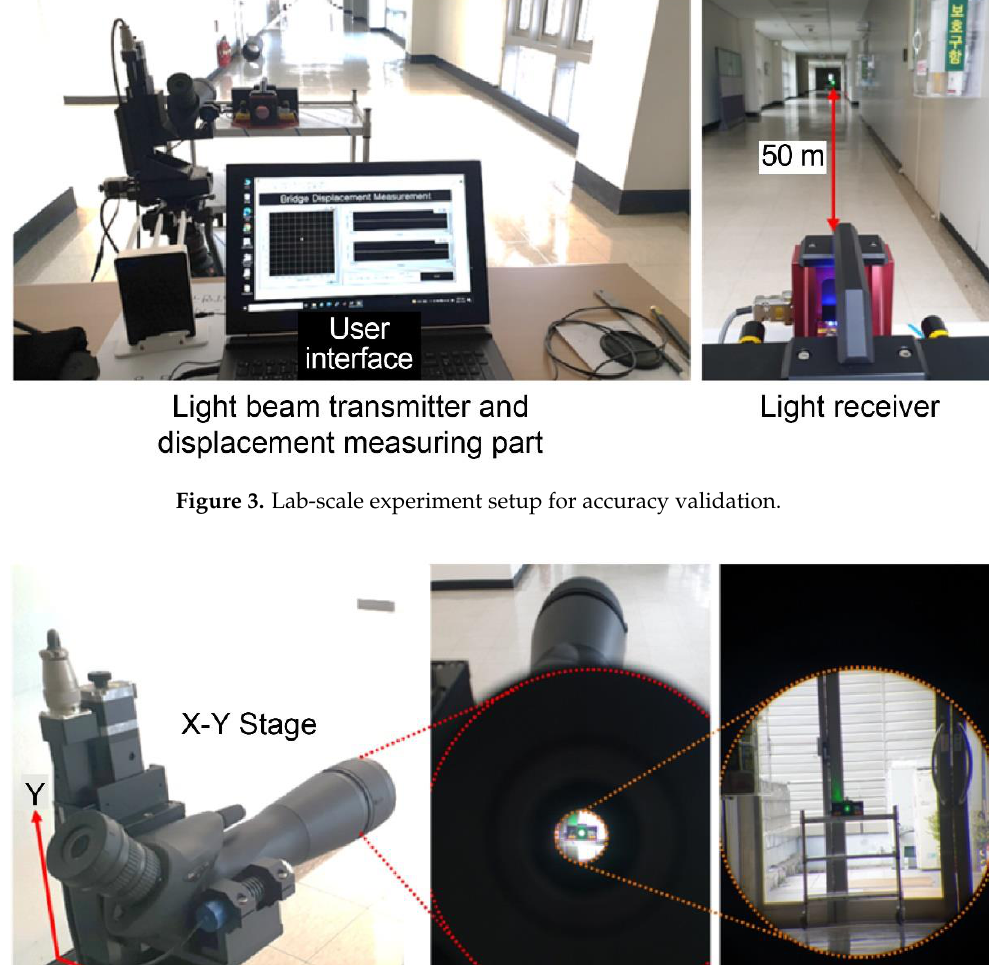
Figure 5. X -axis movement signal comparison (stage control vs. measured displacement) and errors of statics and dynamics ranges . Figure 6. Y -axis movement signal comparison (stage control vs. measured displacement) and errors of statics and dynamics ranges. To analyze the error according to state, we divided the data into (i) a static range where the stage statically waited, and (ii) a dynamic range where its movement was